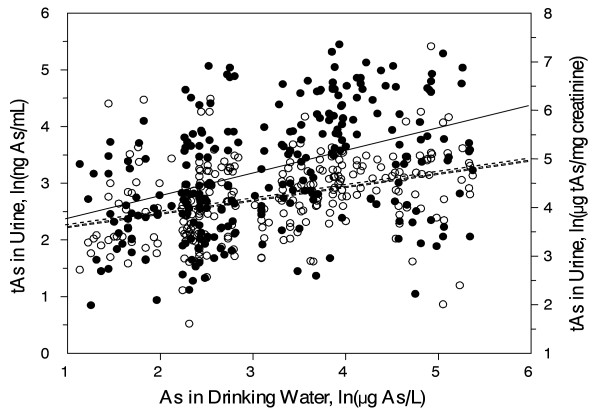
Correlations between logarithmically transformed concentrations of iAs in drinking water and tAs in urines collected from subjects in Zimapán and Lagunera: ● tAs in ng/mL (full line); ○ tAs in μg/mg of creatinine (dashed line).